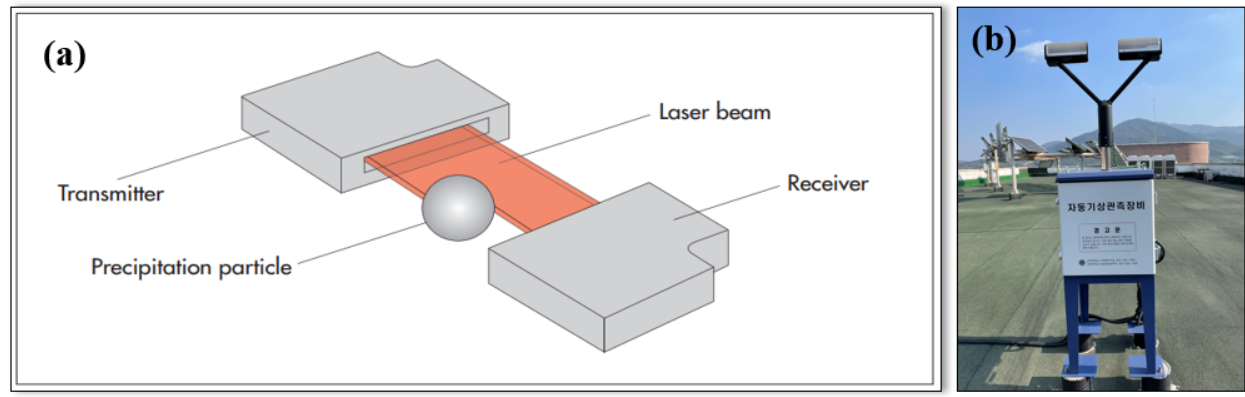
Figure 2. ( a ) Functional principle of the Parsivel 2 disdrometer (Source: Operating instructions Present Wether Sensor OTT Parsivel 2 [35]) and ( b ) the Parsivel 2 located inside the Kyungpook National University, Sangju campus.